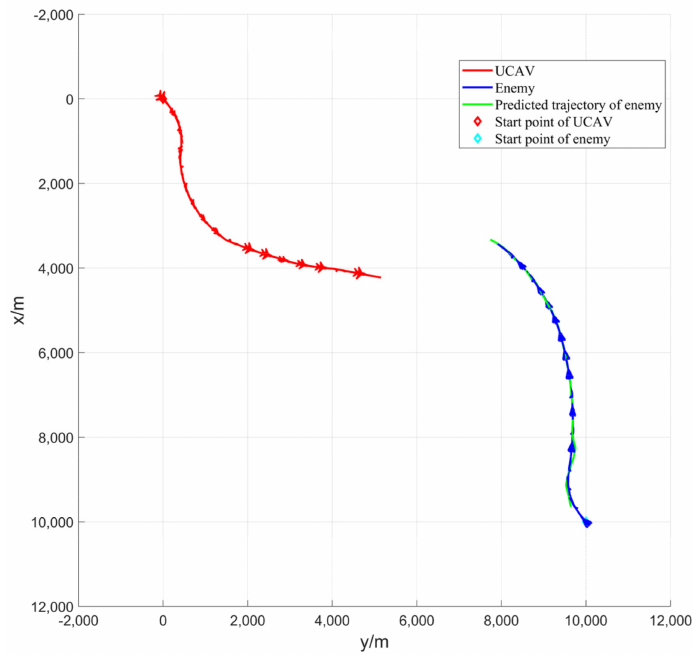
Figure 8. Top view of air combat trajectory and predicted trajectory.